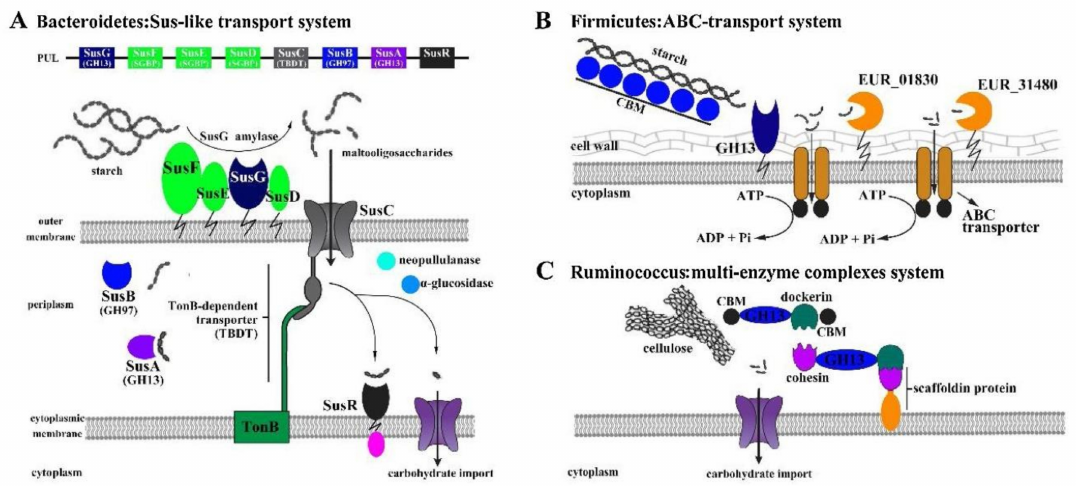
Figure 14. Polysaccharide degradation mechanisms of intestinal bacteria. ( A ) Starch utilization sys- tem (Sus) in Bacteroides thetaiotaomicron and their genomic organization of polysaccharide utilization loci (PUL). ( B ) ATP-binding cassette transport system in Eubacterium rectale . ( C ) Multi-enzyme com- plexes system in Ruminococcus champanellensis . Reprinted with permission from Ref. [164]. Copyright 2022, Elsevier.